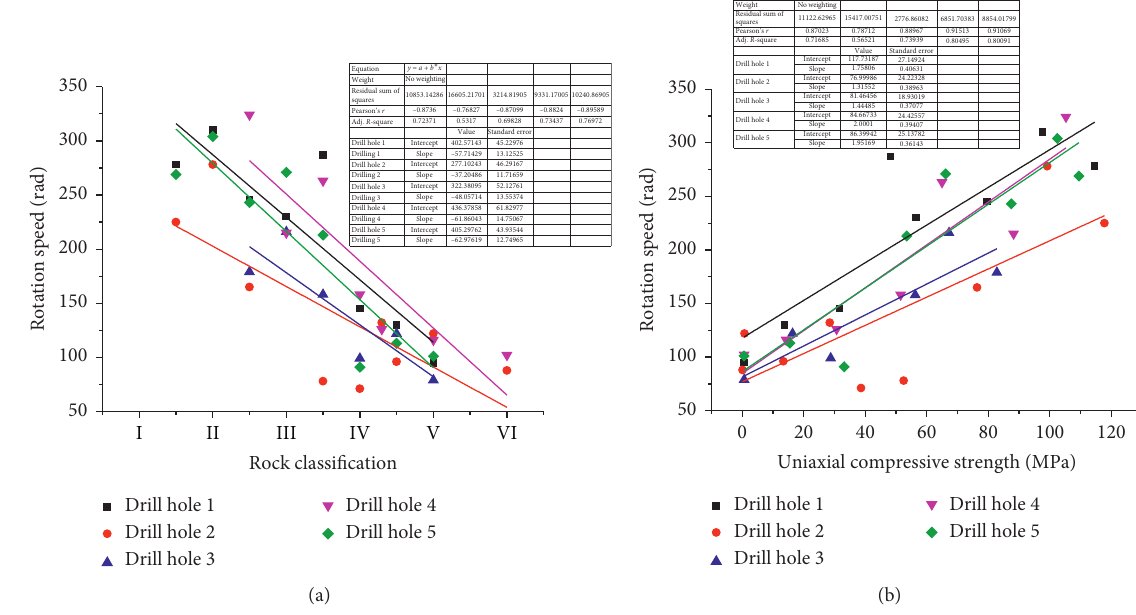
Figure 11: Relationship between rock classification, compressive strength, and bit rotation speed.